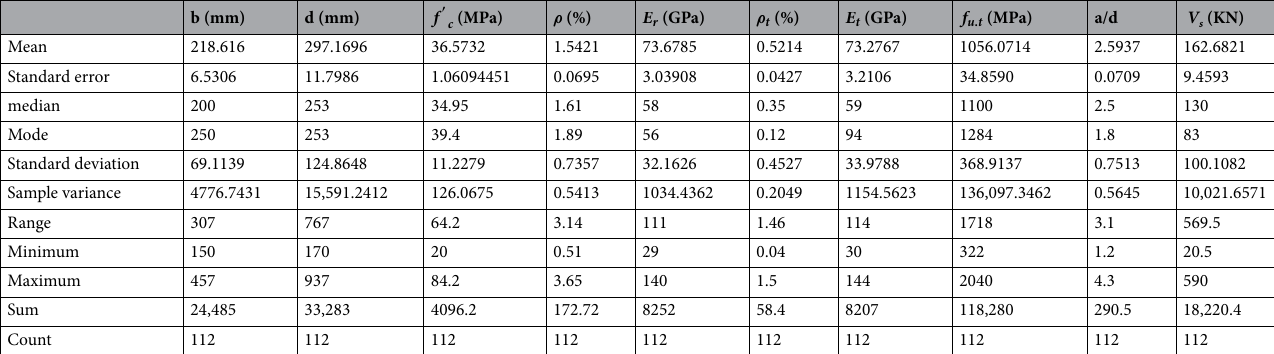
Table 1. Statistical characteristics of collected